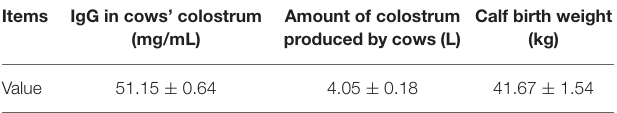
TABLE 1 | Screening information for cows and calves.